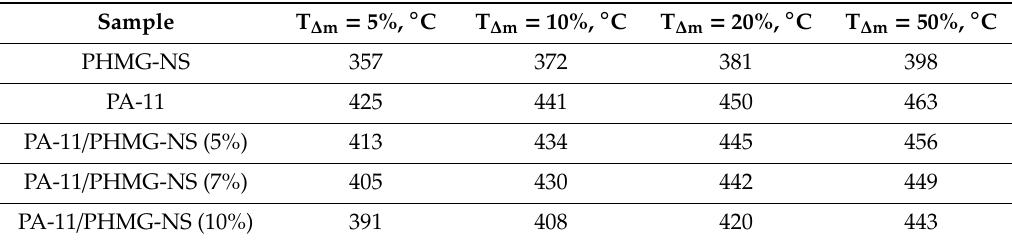
Table 3. TGA data for PHMG-NS and PA-11 / PHMG-NS composite*.